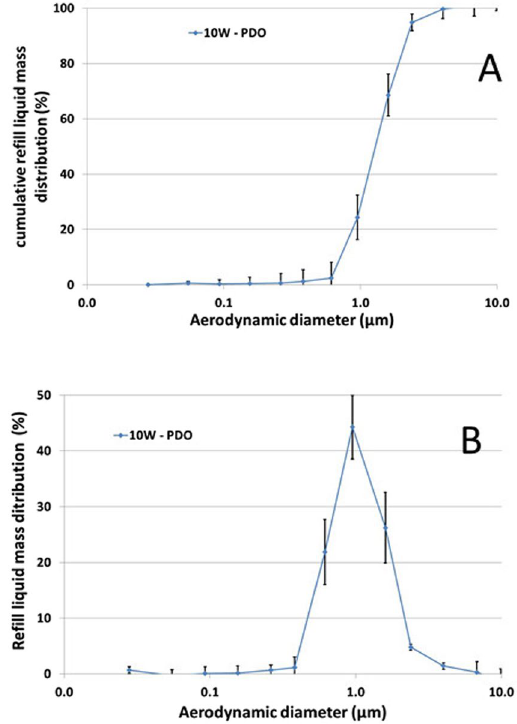
Figure 4. DLPI Impactor-collected data. ( A ) Cumulative mass distribution for the PDO formulation with a power level of EC fixed at 10 W. Experiments performed in triplicate. ( B ) Frequency mass distribution for the PDO formulation with a power level of EC fixed at 10 W. Experiments performed in triplicate.